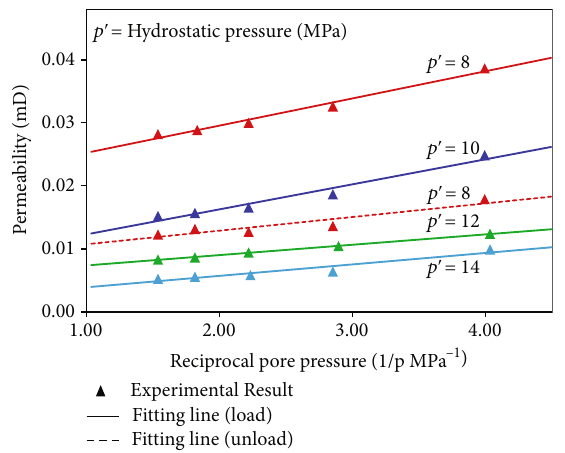
Figure 3: The slippage e ff ect fi tting process of sample C1 under hydrostatic stress. Table 1: Coal intrinsic permeability under di ff erent hydrostatic stresses ( × 10 -2 mD).